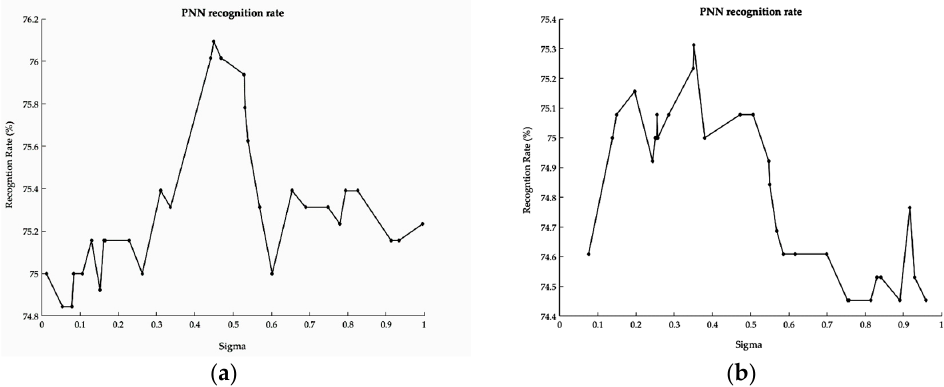
Figure 6. PNN results for various smoothing parameter values for ( a ) arousal and ( b ) valence emotion.